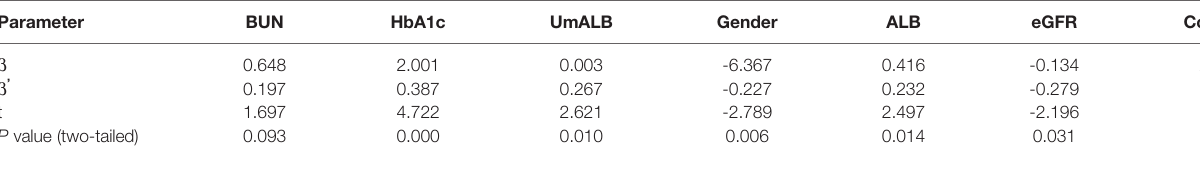
TABLE 3 | The in fl uence factors of ACE established by multiple logistic regression model. Parameter